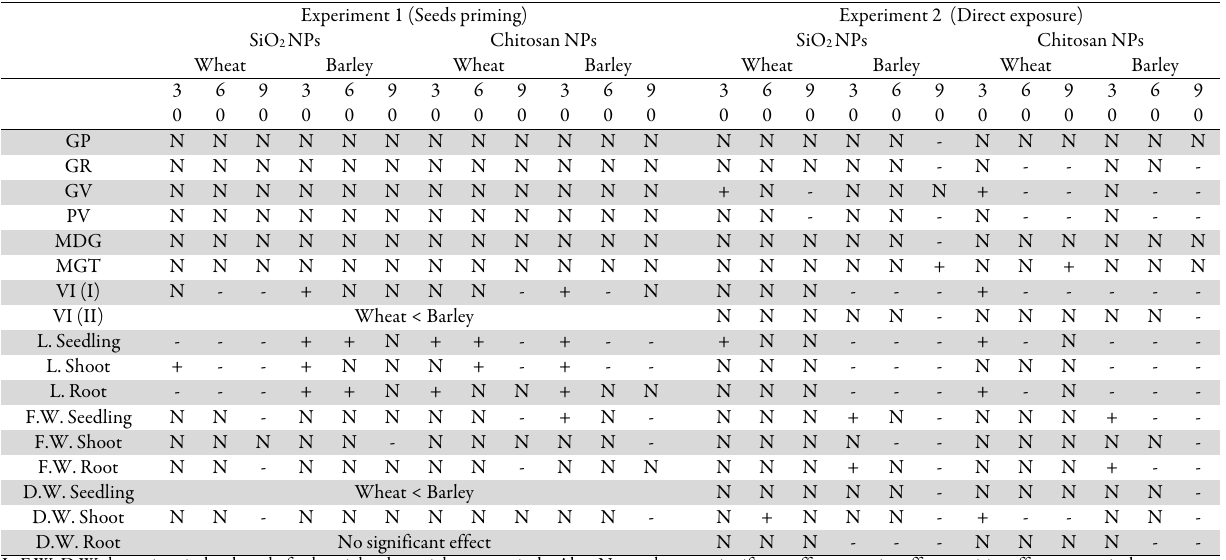
L, F.W, D.W show vigor index, length, fresh weight, dry weight, respectively. Means by the uncommon letter in each row and column are significantly different according to Duncan tests (p<0.05). Table 8. Summary of results for studying effects of NPs on germination parameters as compared to the control Experiment 1 (Seeds